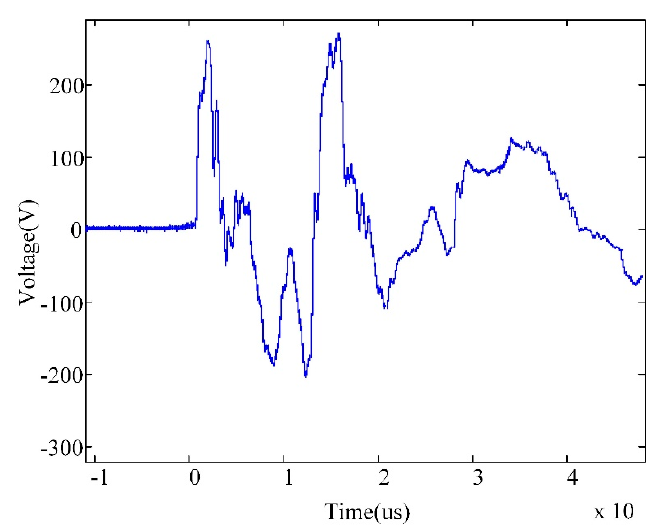
Figure 12. The aerial-mode component of the measured voltages.